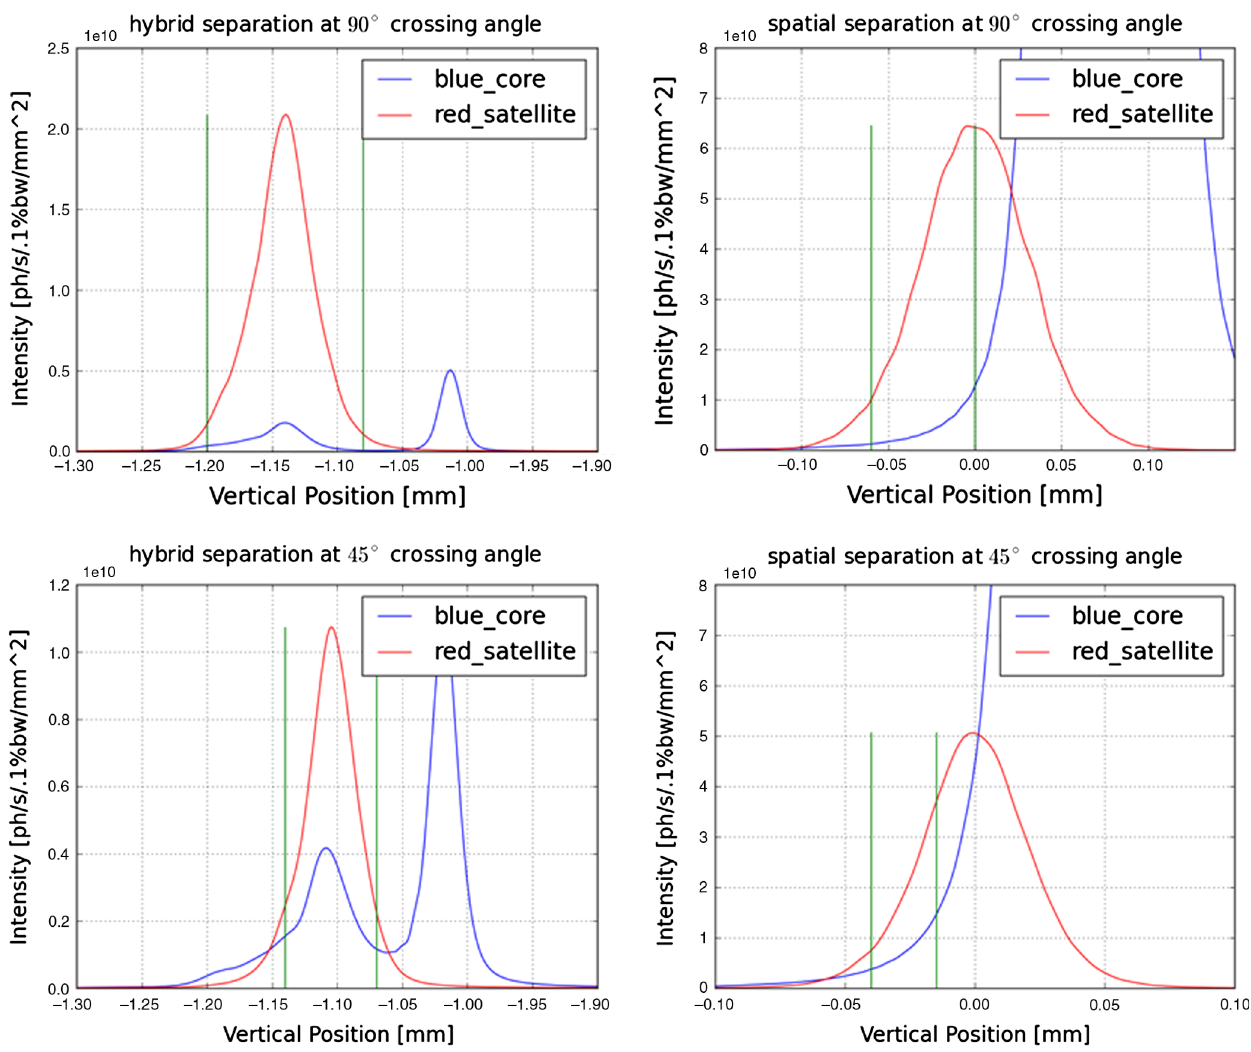
FIG. 15. Vertical cuts of the intensity distribution at the observation plane of the core (blue curve) and the satellite (red curve) using different separation methods for 90° and 45° respectively. The green lines represent the apertures used to block the main part of the core radiation for noise reduction. The power calculated is proportional to the area between the green lines. Upper-left figure: hybrid separation at 90°. Upper-right figure: spatial separation at 90°. Lower-left figure: hybrid separation at 45°. Lower-right figure: spatial separation